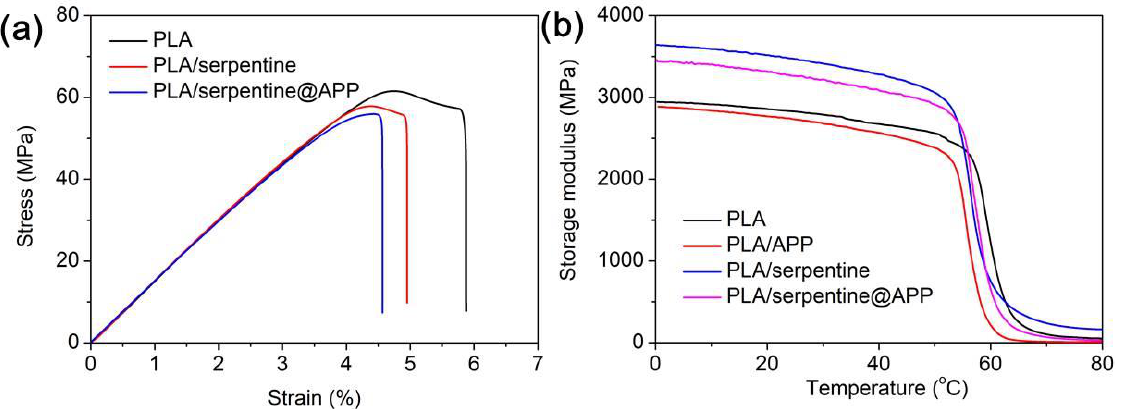
Figure 11. ( a ) Tensile stress versus strain of tensile test, ( b ) storage modulus of dynamical mechanical analysis of pure PLA and its composites. Table 4. Tensile properties for pure PLA and its composites.